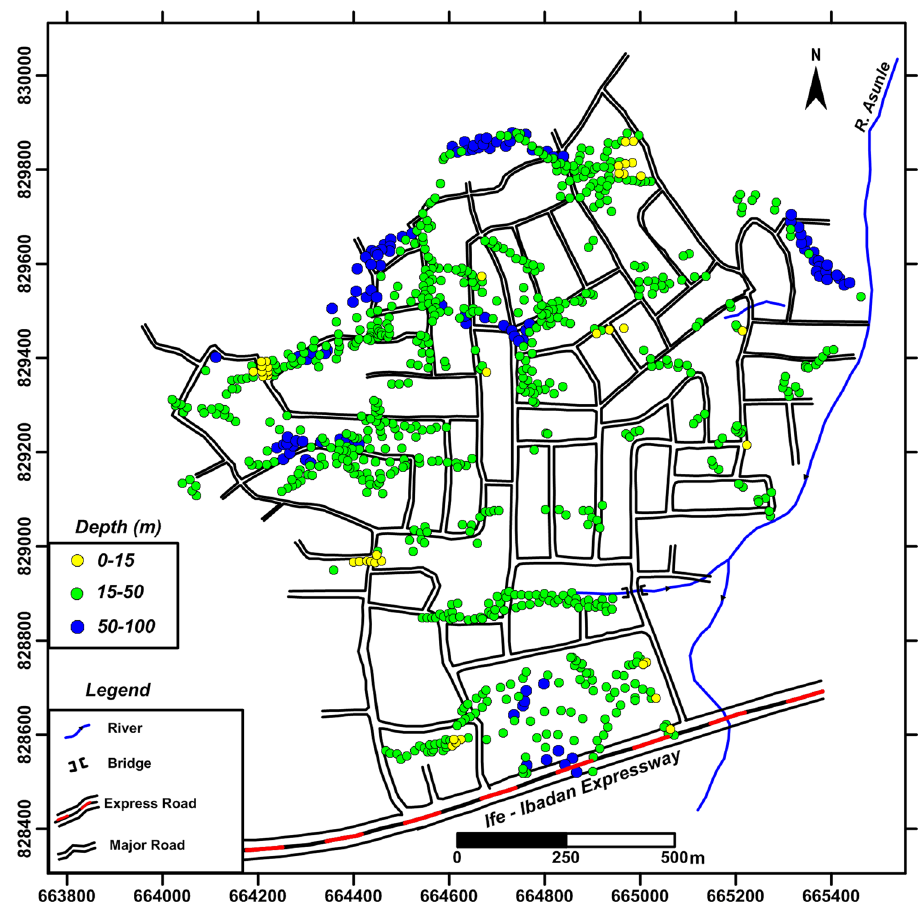
Fig. 8 3D Euler deconvolution solution map (using structural index ( η ) = 0.5, window size of 10 and tolerance of 20)